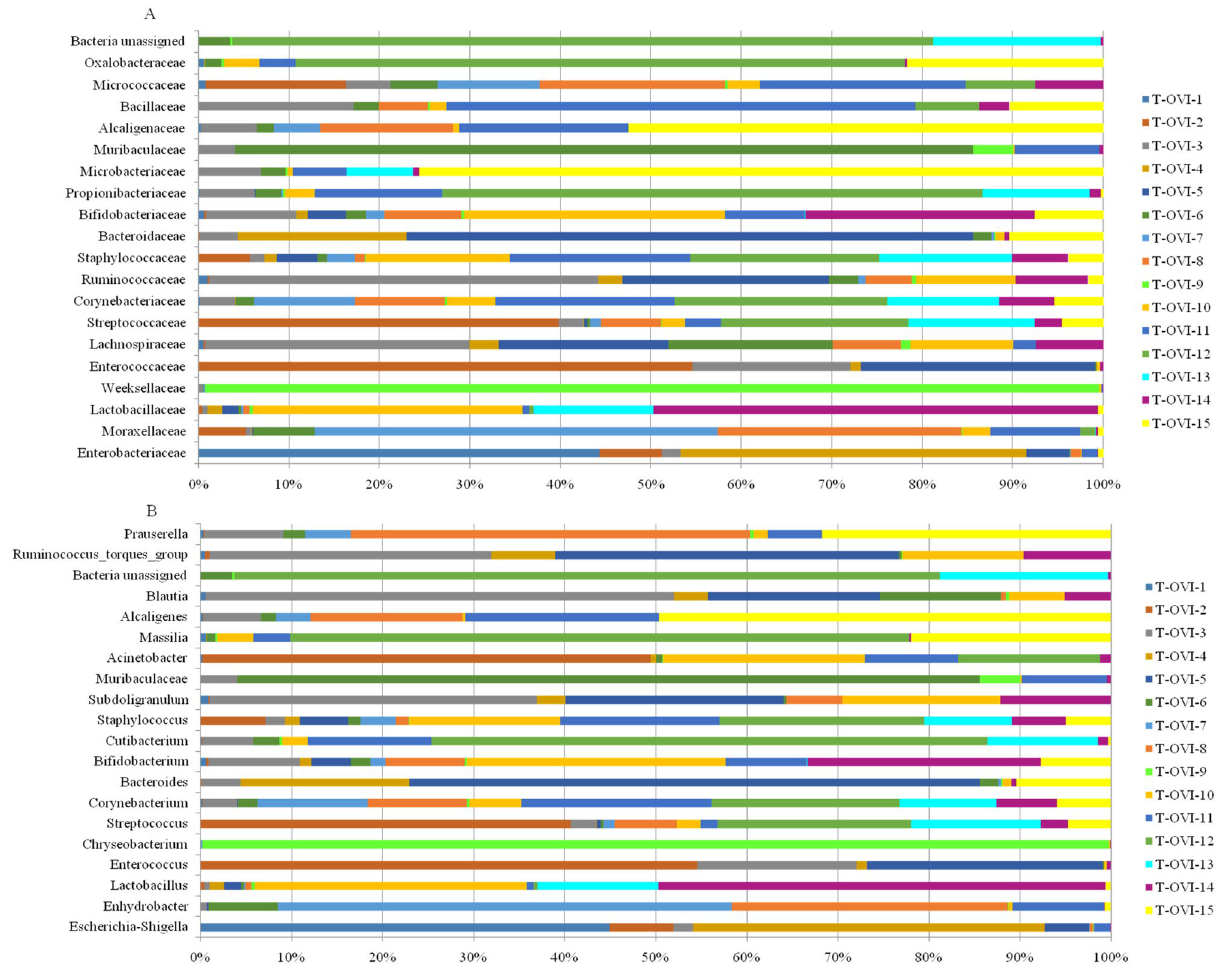
Figure 4. ( A ) Relative abundance of 20 most common ASV at the family level in each sample; ( B ) Relative abundance of 20 most common ASV at the genus level in each